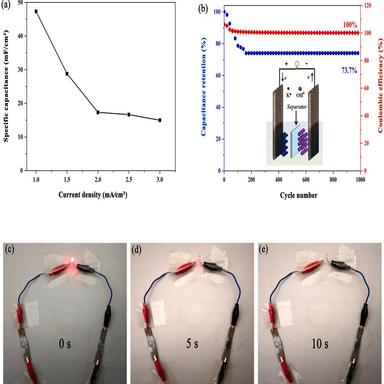
Electrochemical performance of CdSe (40 min) symmetric solid supercapacitor (a) specific capacitance line diagrams, (b) cycling stability and coulombic efficiency for 1000 cycles at the current density of 1 mA/cm2 (The inset is a schematic diagram of CdSe symmetric solid supercapacitor) and c-e LED in series were lit up in different stages ((c) 0 s, (d) 5 s, (e) 10 s) by two symmetric solid supercapacitors devices in series.